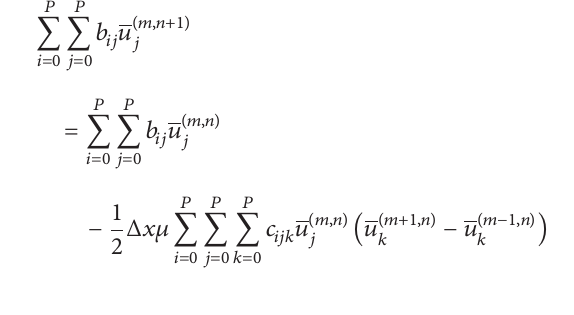
to those used for 𝜓 𝑖 . After executing the same procedure as in Case 1, it